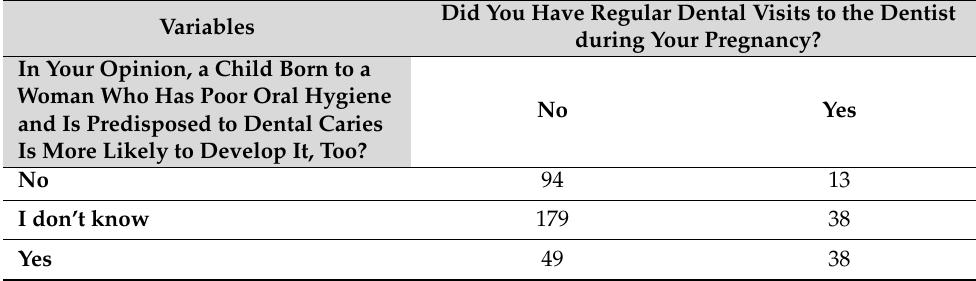
Table 7. Distribution according to information received by dental professionals about regular dental visits during pregnancy. Variables